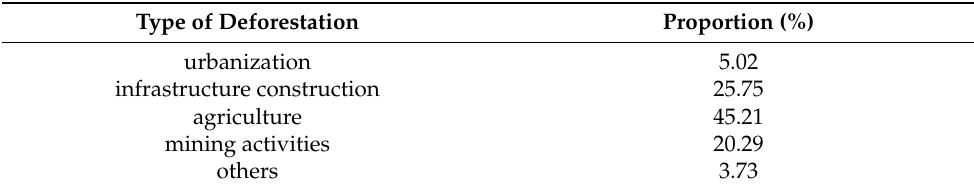
Table 10. Factors in